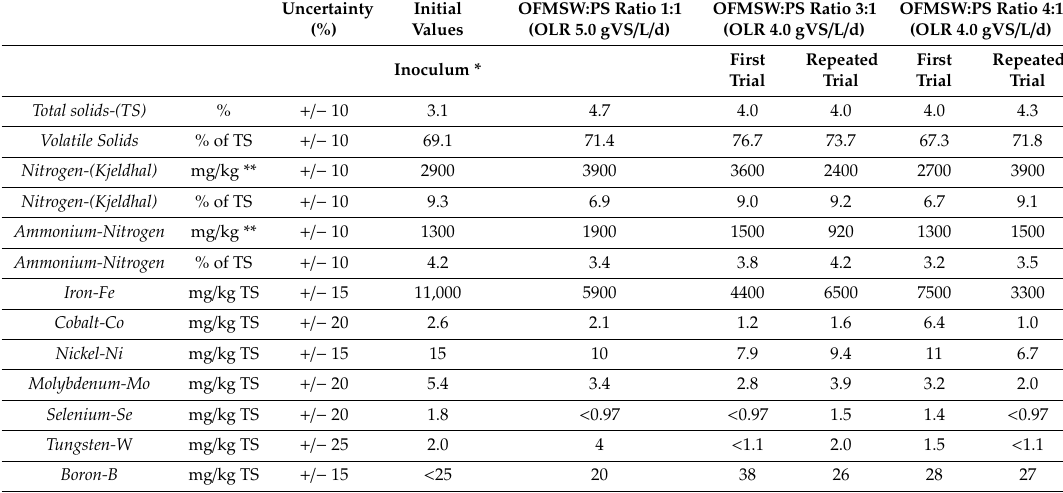
Table 2. The level of nutrients, i.e., nitrogen and trace elements, in the reactors during co-digestion. The analyses were conducted on digested residue samples taken from the reactors at steady state conditions, i.e., at the end of the operation time corresponding to 3 hydraulic retention time (HRTs) when reaching maximum organic loading rates (OLRs). Initial values are showing the analyses data for the inoculum before the feeding